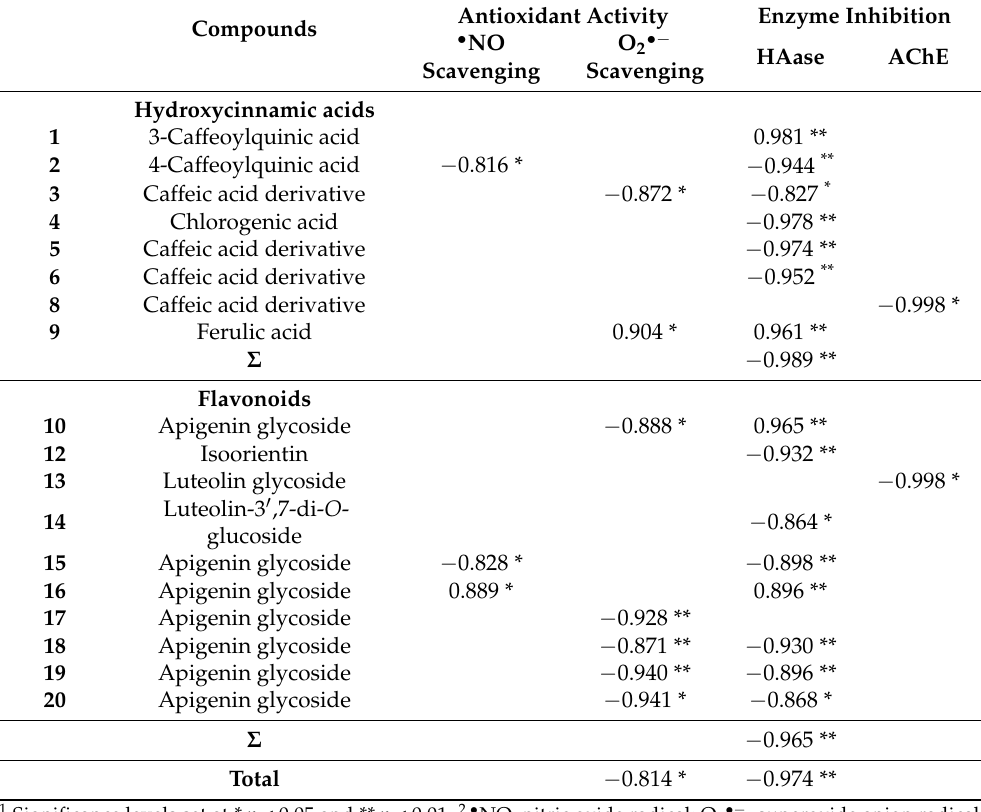
Table 3. Correlation between the biological activities and the chemical profile of camel grass extracts 1,2